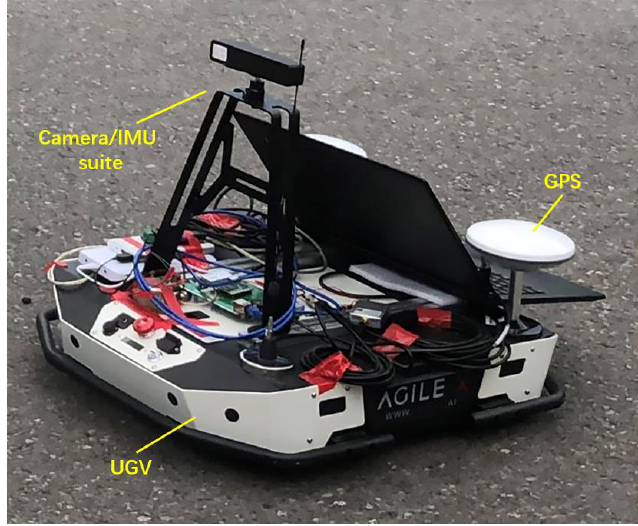
Figure 12. The UGV experiment